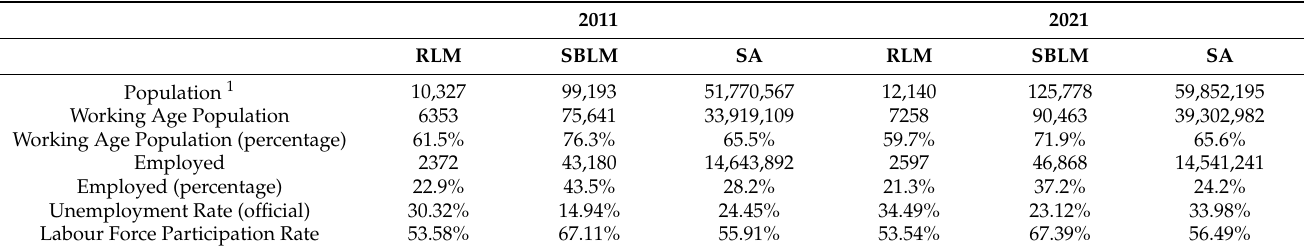
Table 3. Labour market in RLM and SBLM.